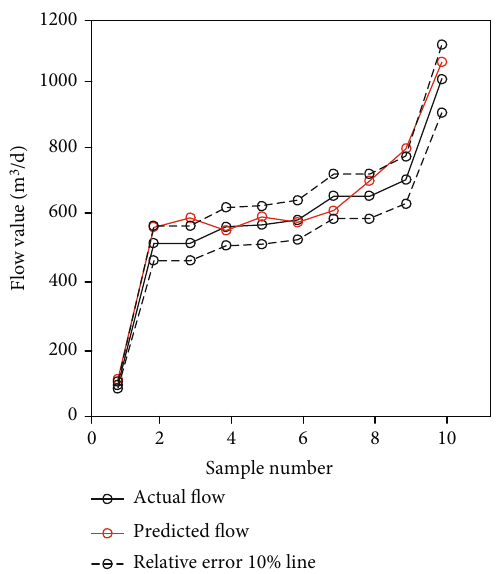
Figure 19: Histogram of the predicted value error of model 2.